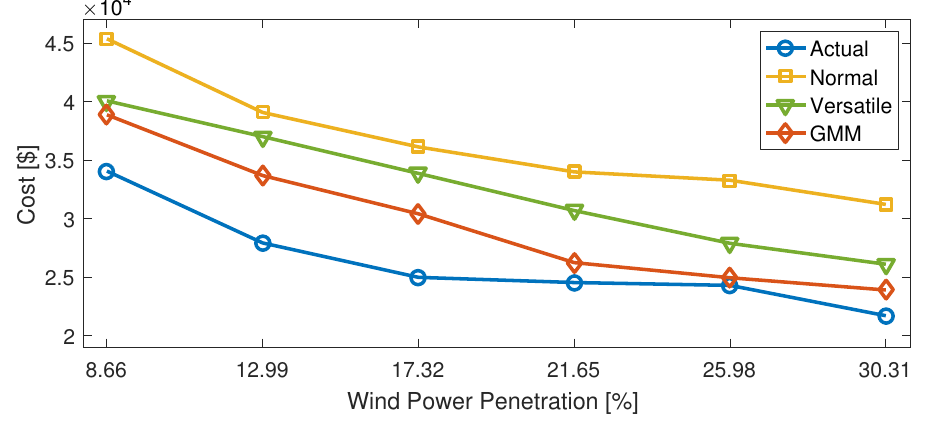
Figure 6. Operation cost comparisons with different wind power